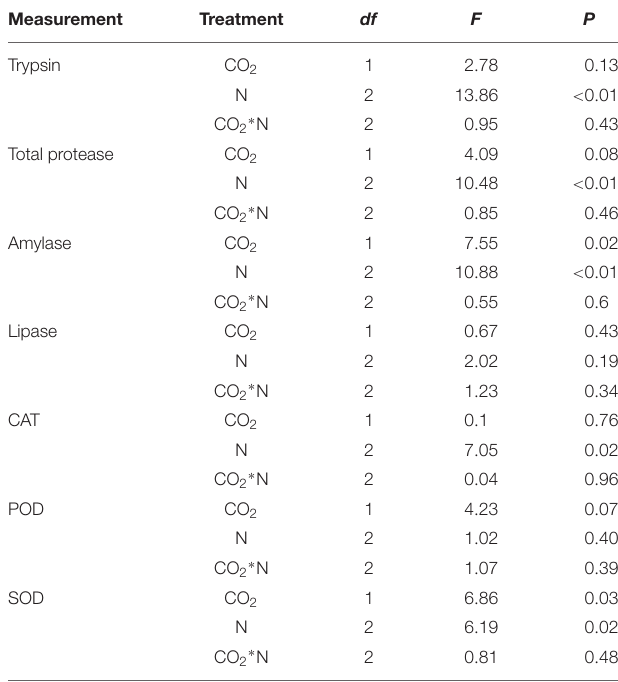
TABLE 5 | Summary of ANOVA results for effects of elevated CO 2 and increased nitrogen fertilization on digestive and protective system enzymes of Ostrinia furnacalis